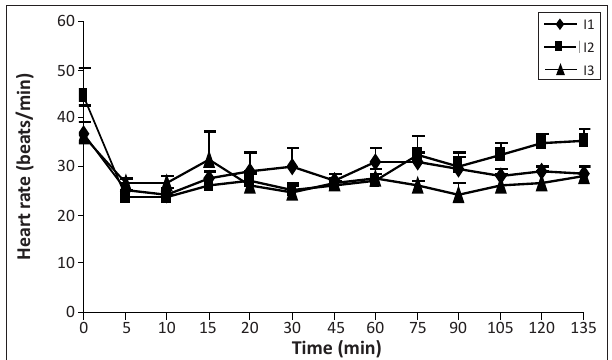
FIGURE 6: Mean ± standard error of heart rate (beats/min) in water buffaloes of different